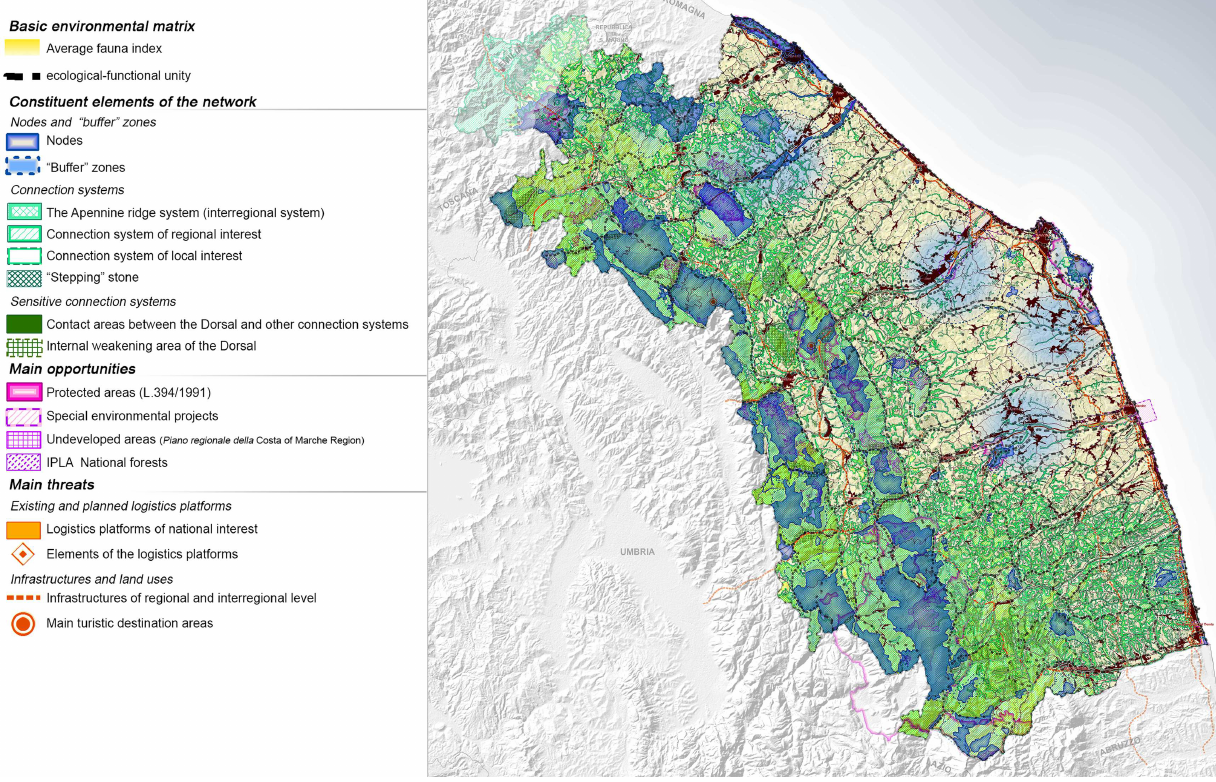
Figure 3. The case study of the ecological network of the Marche Region (REM), Italy. The map shows to Project strategy, that aims to: i) facing and planning the problem of protection and evaluation of the regional environmental heritage as a whole; ii) defining an area of intervention that concerns the entire regional territory (not just nodes and corridors), defining the forms of contact with Marche landscapes; iii) managing the regional environmental system, governing the functions of geographical and typological unity; iv) establishing modes of interaction between the REM and regional planning and programming instruments (Source: Author’s archive from the Research Project “The Ecological Network of the Marche